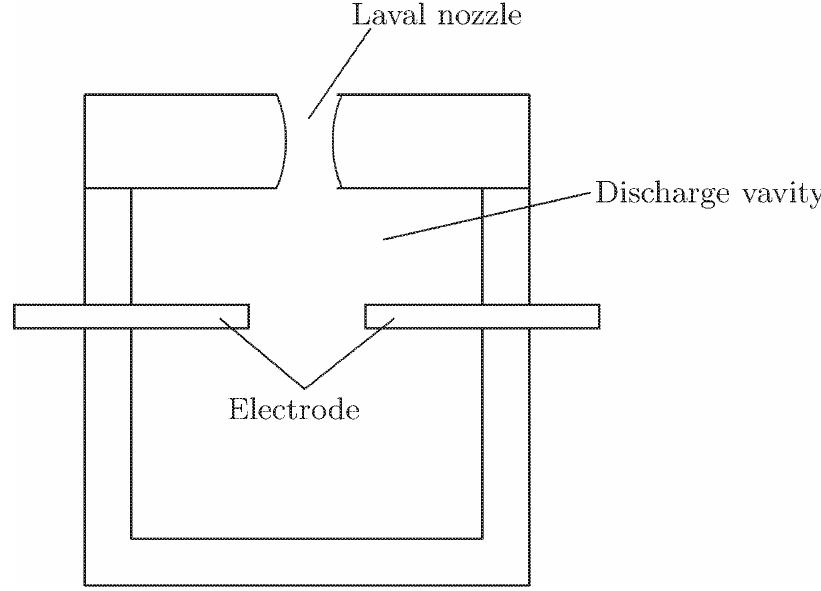
Figure 33. Schematic of the SparkJet and the Laval-shape